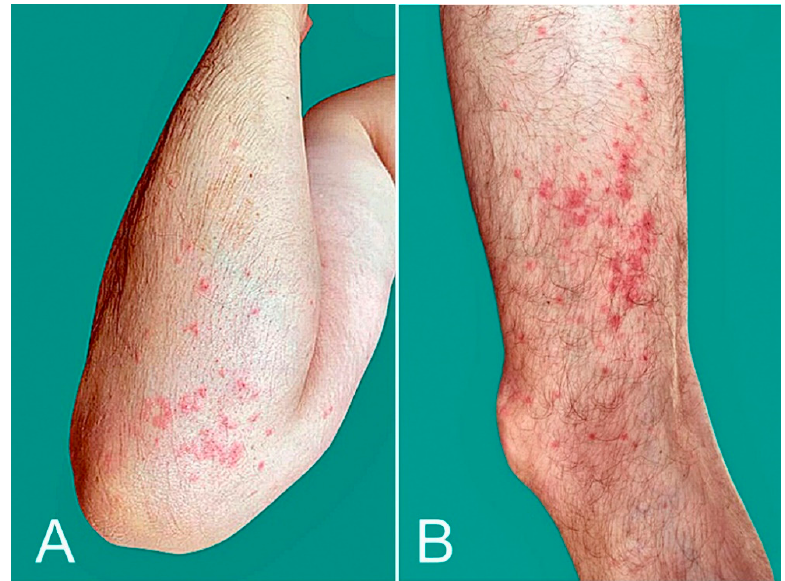
Figure 5. Purpura: palpable purpuric papules over upper ( A ) and lower limbs ( B ) developed 10 days after AZD1222